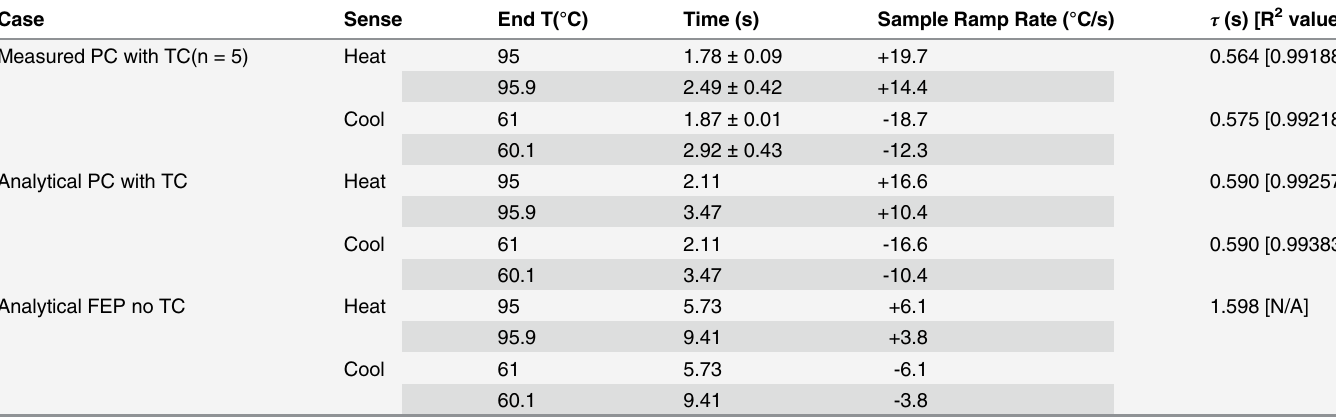
Table 2. Measured and analytically predicted transitions between 60°C and 96°C for samples in polycarbonate (PC) and FEP tubing with and with- out a thermocouple (TC) present. Case Sense End T(°C) Time (s) Sample Ramp Rate (°C/s) τ (s) [R 2 value] Measured PC with TC(n =